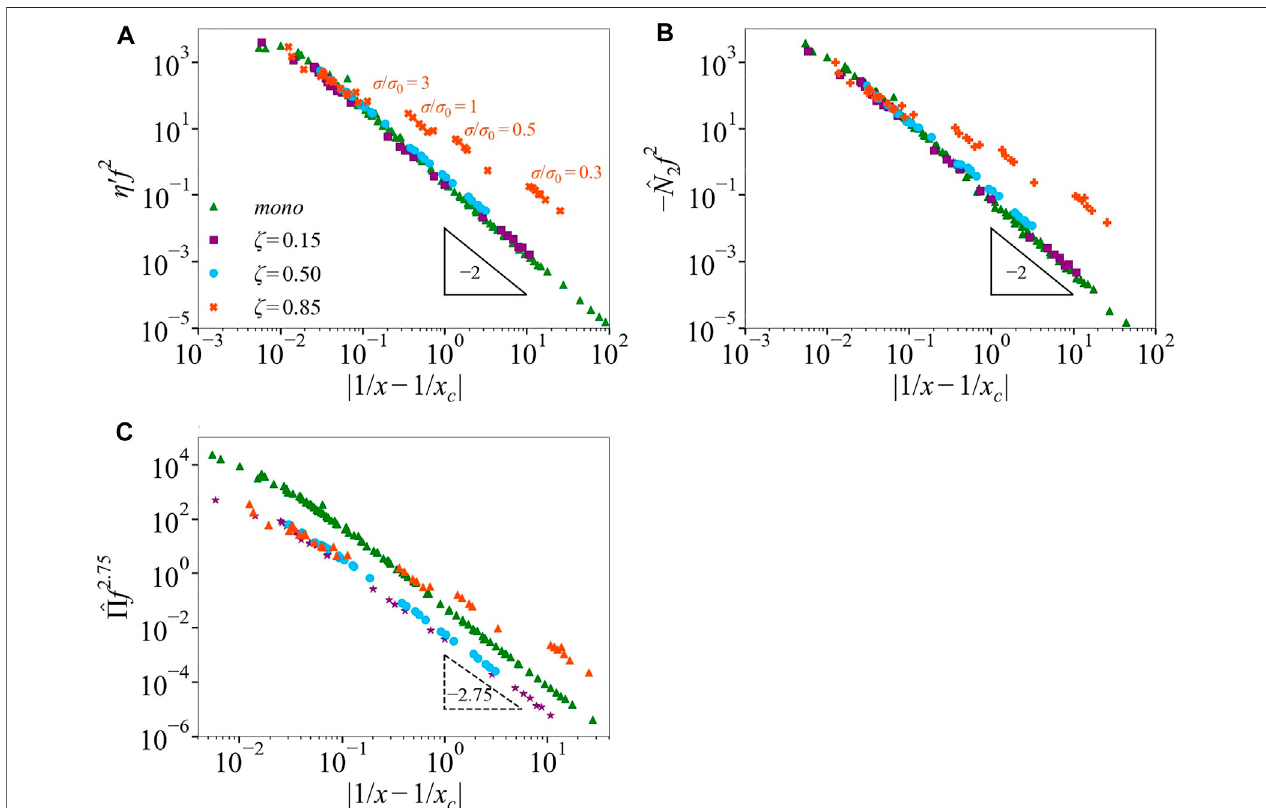
(cid:1) − ^ N ( f ( σ )) 2 , (C) H Π (cid:1) ^ Π ( f ( σ )) 2 versus|1/ x − 1/ x |formonodispersesuspensionswith δ =1.4, ζ 2 c 2